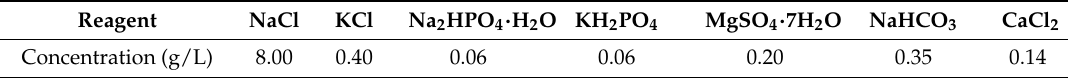
Table 2. Composition of Hanks’ solution using for immersion